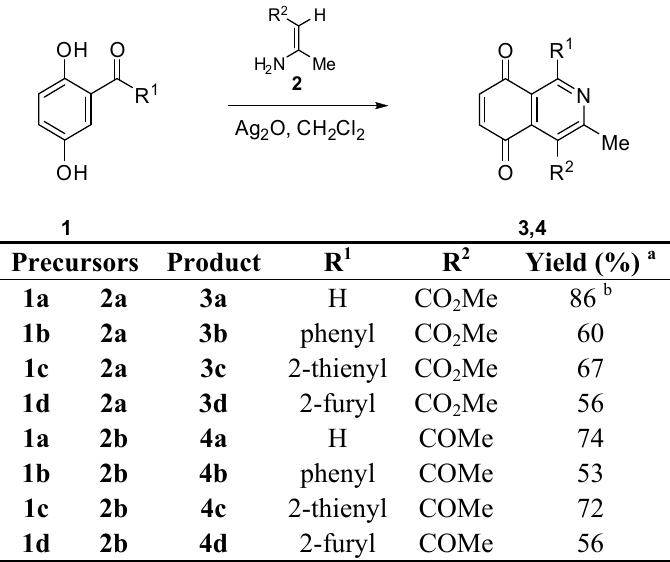
Table 1. Preparation of 1-arylisoquinoline-5,8-quinones 3 and 4 .